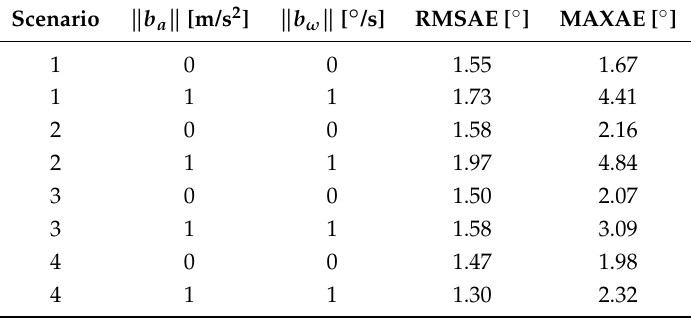
Table 1. Shows the RMSAE (71) and MAXAE (72) after M = 100 runs with and without artificial bias for the four